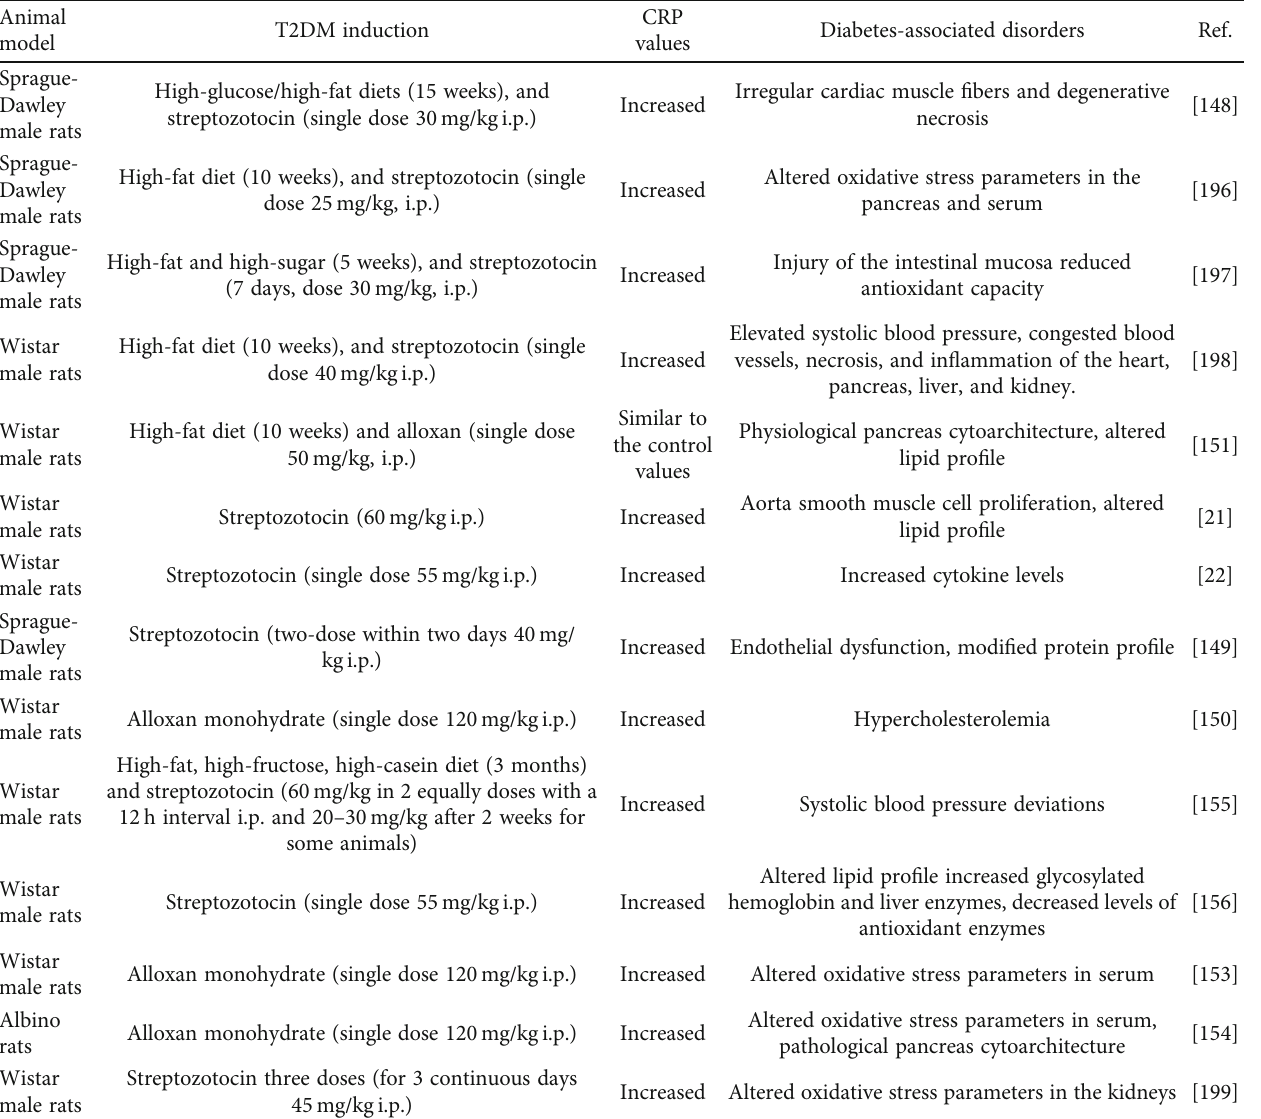
Table 1: CRP values in animal model